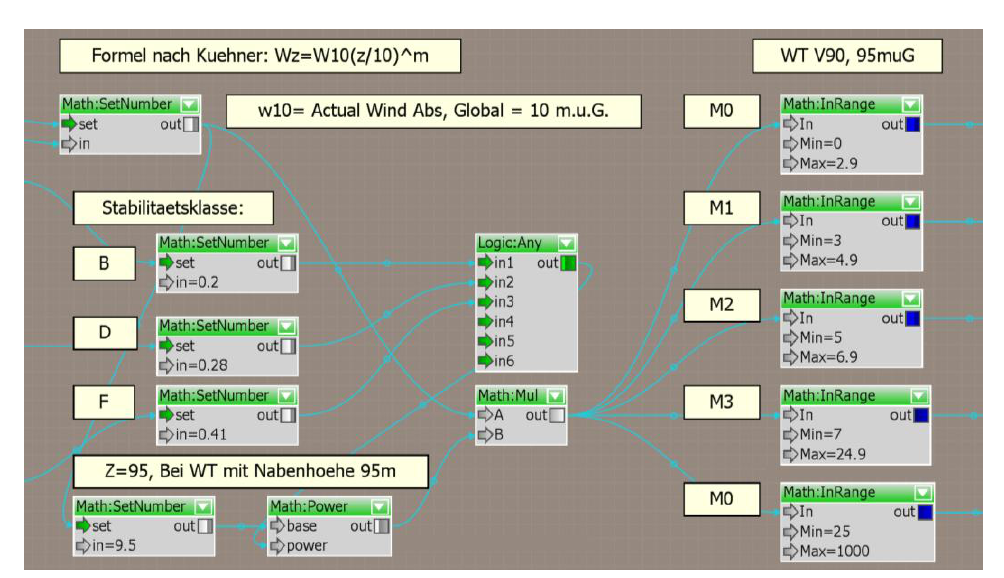
Figure 3. Section of the ―Flow Graph‖ script developed in CryENGINE to control the specific parameters for wind speed profile calculation and corresponding wind turbine rotation in the virtual landscape